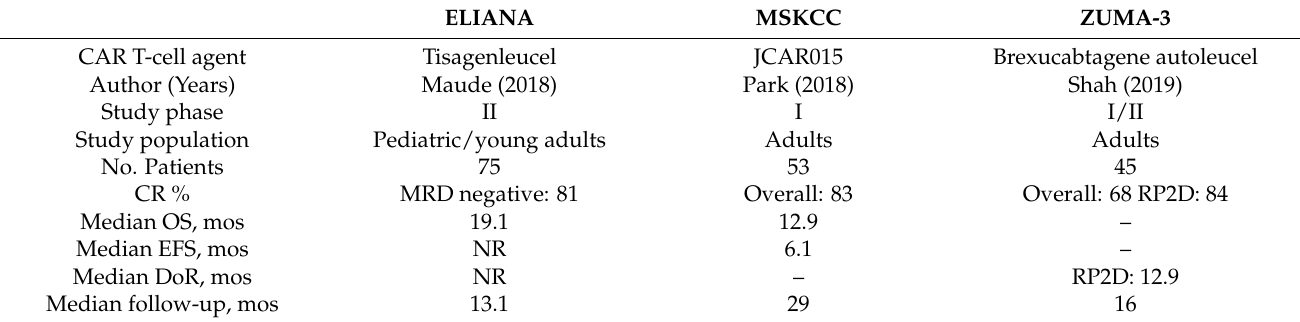
Table 3. Key anti-CD19 CAR T-cell therapy trials in relapsed/refractory B acute lymphoblastic